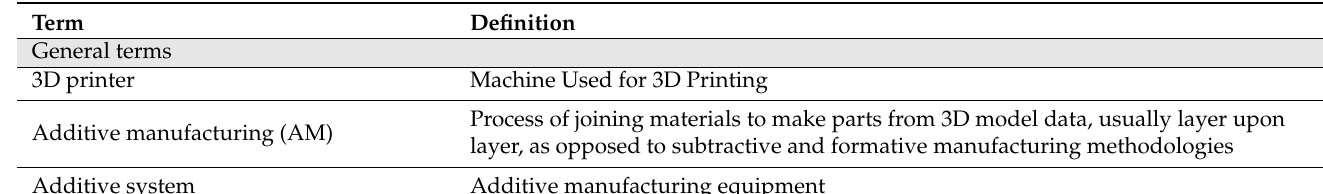
Table 2. Terms and definition of additive manufacturing in ISO/ASTM